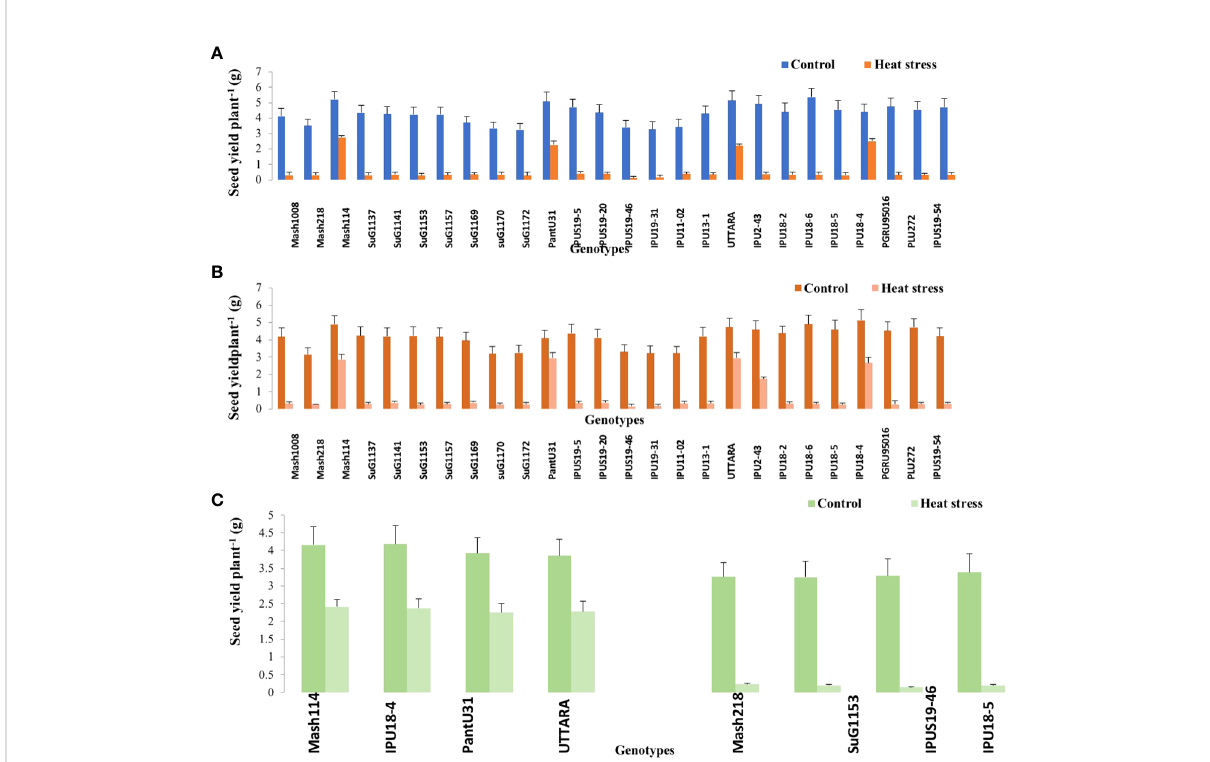
FIGURE 3 Seed yield plant -1 of Urdbean genotypes under control (normal-sown; Control) and heat stress environment during 2018 (A) ,2019 (B) and in controlled environment of growth chamber ( C ; GC). LSD values (P < 0.05); genotype × treatment: 1.3 (2018), 1.5 (2019), 1.3 (GC). Values are means + SE. (n =